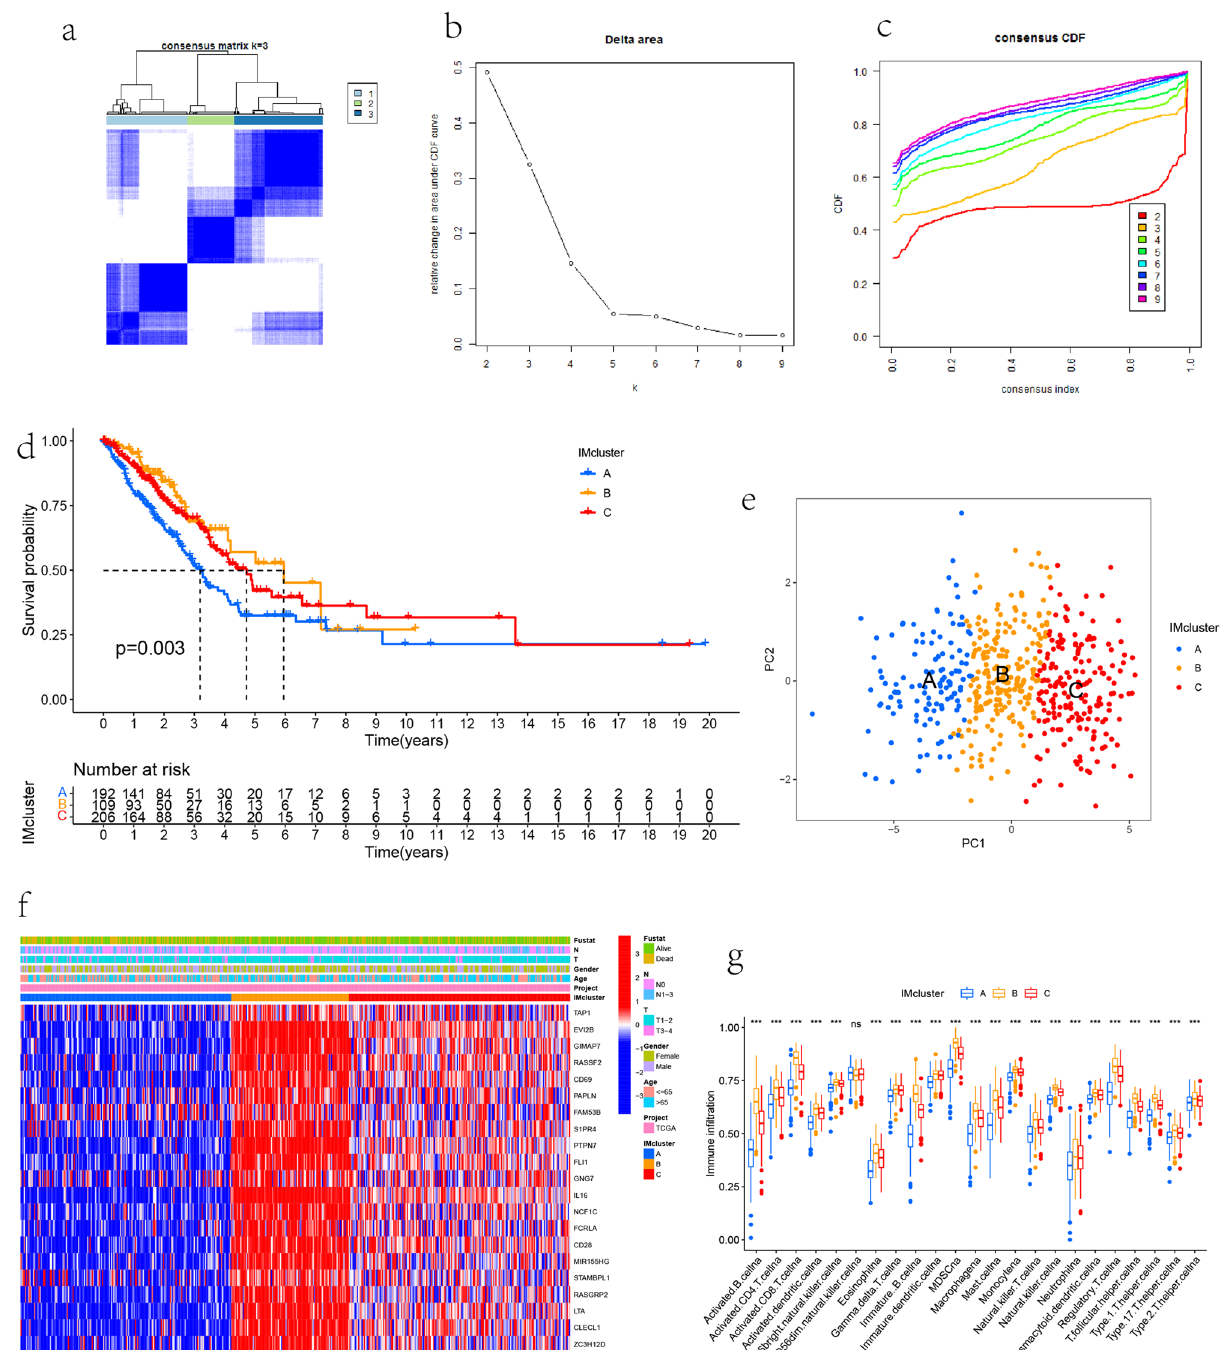
Figure 3. OS curve, expression and immune cell infiltration among clusters. ( a – c ) Consensus clustering heat map of lung adenocarcinoma (LUAD) patients when k = 3. ( b ) Delta area curve of consensus clustering represents the relative change of area under the cumulative distribution function (CDF) curve. ( c ) For consensus clustering CDF with k = 2–9. ( d ) Kaplan Meier OS curve among the three clusters. ( e ) Principal component analysis (PCA) showed the sample distribution of the three clusters. ( f ) The expression of differentially expressed genes in the three clusters and their clinicopathological characteristics. Red and blue represent high and low expressions of genes respectively. ( g ) The degree of infiltration of immune cells among the three clusters. The P value is displayed as: ns: not significant *P < 0.05; **P < 0.01; ***P <